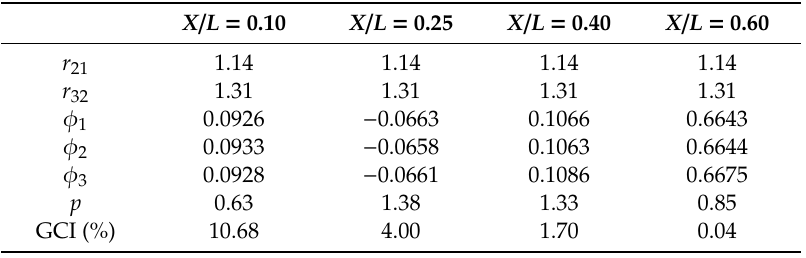
Table 1. Showcased calculations of grid convergence index (GCI) in P / ( ρ gd c ). X / L = 0.10 X / L = 0.25